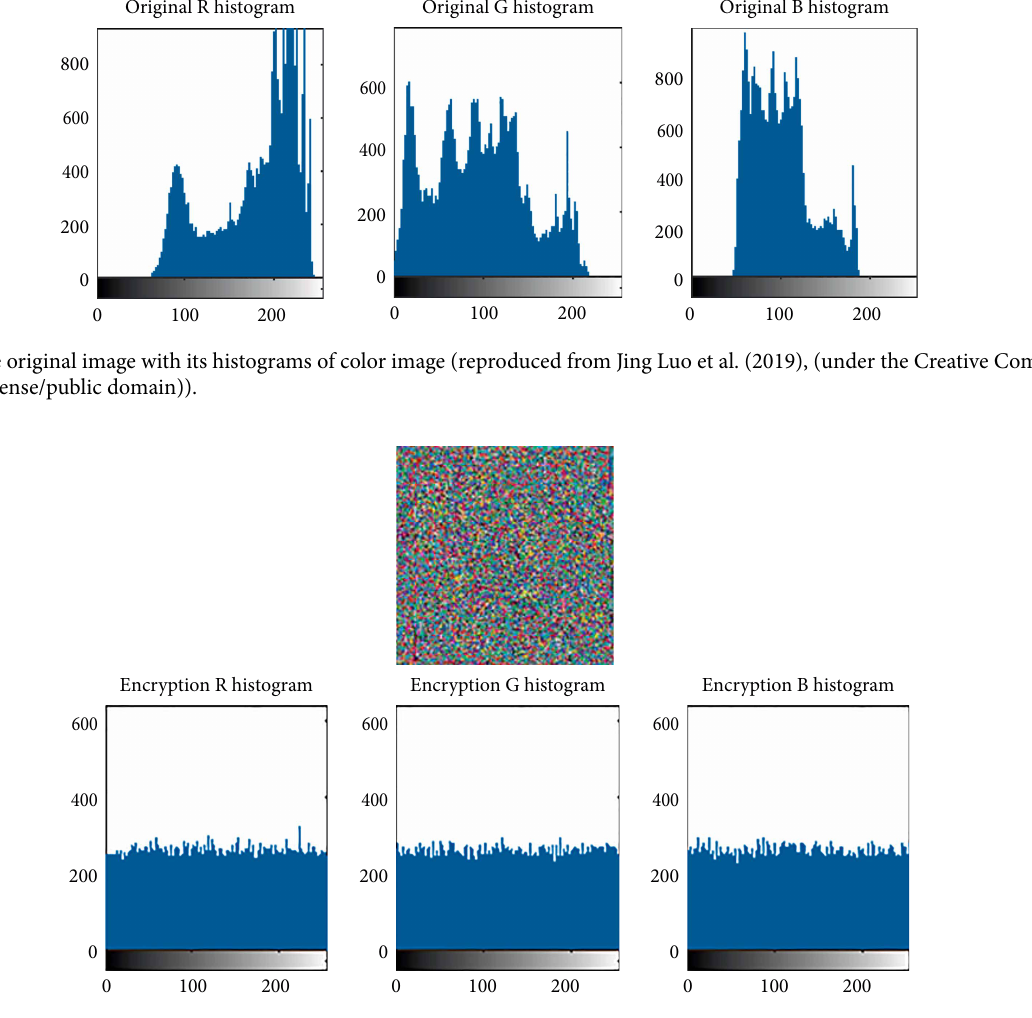
Figure 14: The encrypted image with its histograms (reproduced from Jing Luo et al. (2019), (under the Creative Commons Attribution License/public